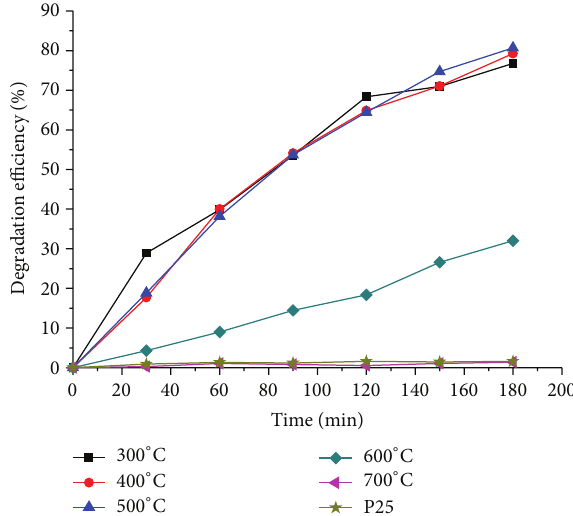
Figure 7: Photocatalytic activity of Mo-P25 and P25 with different calcination